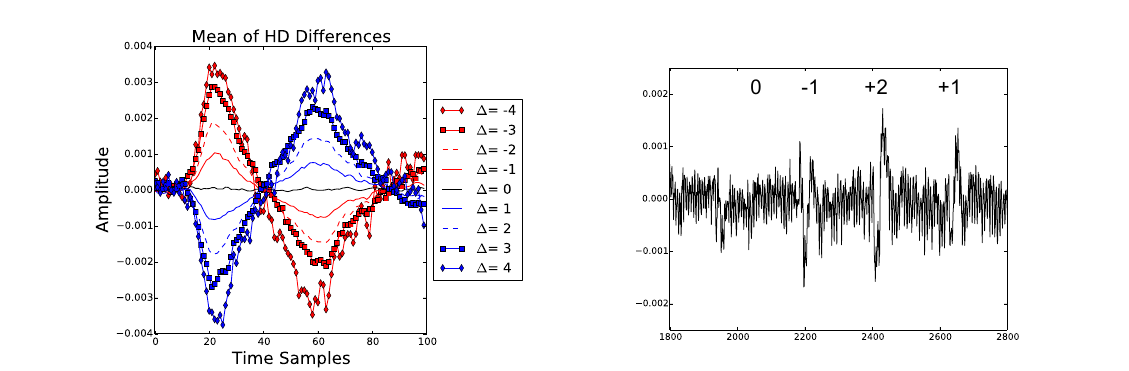
Figure 15: Mean for each class of HD differ- ence